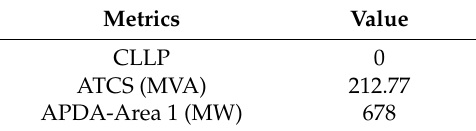
Table 8. The calculation result of during-disaster resistance.